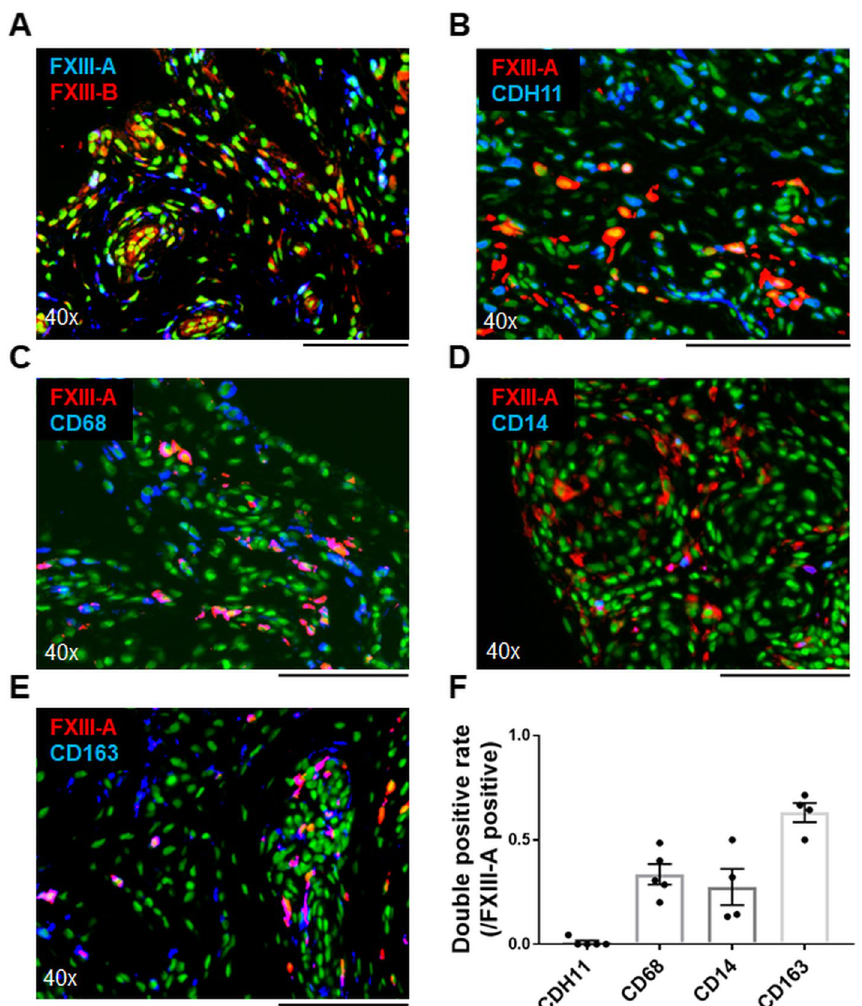
Fig. 2 Macrophages produce FXIII-A in RA synovial tissues. A – E Dual-fluorescent immunohistochemistry (IHC) for synovial tissues collected from patients with RA. Cell nuclei were stained with acridine orange. A Merged anti-FXIII-A (blue) and anti-FXIII-B (red) antibodies and nuclear staining (green). B – E Anti-FXIII-A antibodies (red), nuclear staining (green), and each cell-surface marker antibody (blue) were merged. B Anti-CDH11 antibody, C anti-CD68 antibody, D anti-CD14 antibody, and E anti-CD163 antibody. F Percentage of positive cells for each antibody among FXIII-A-positive cells ( n 4–5, each). Data are presented as mean SEM. A – E Black scale bar 100 = ± =